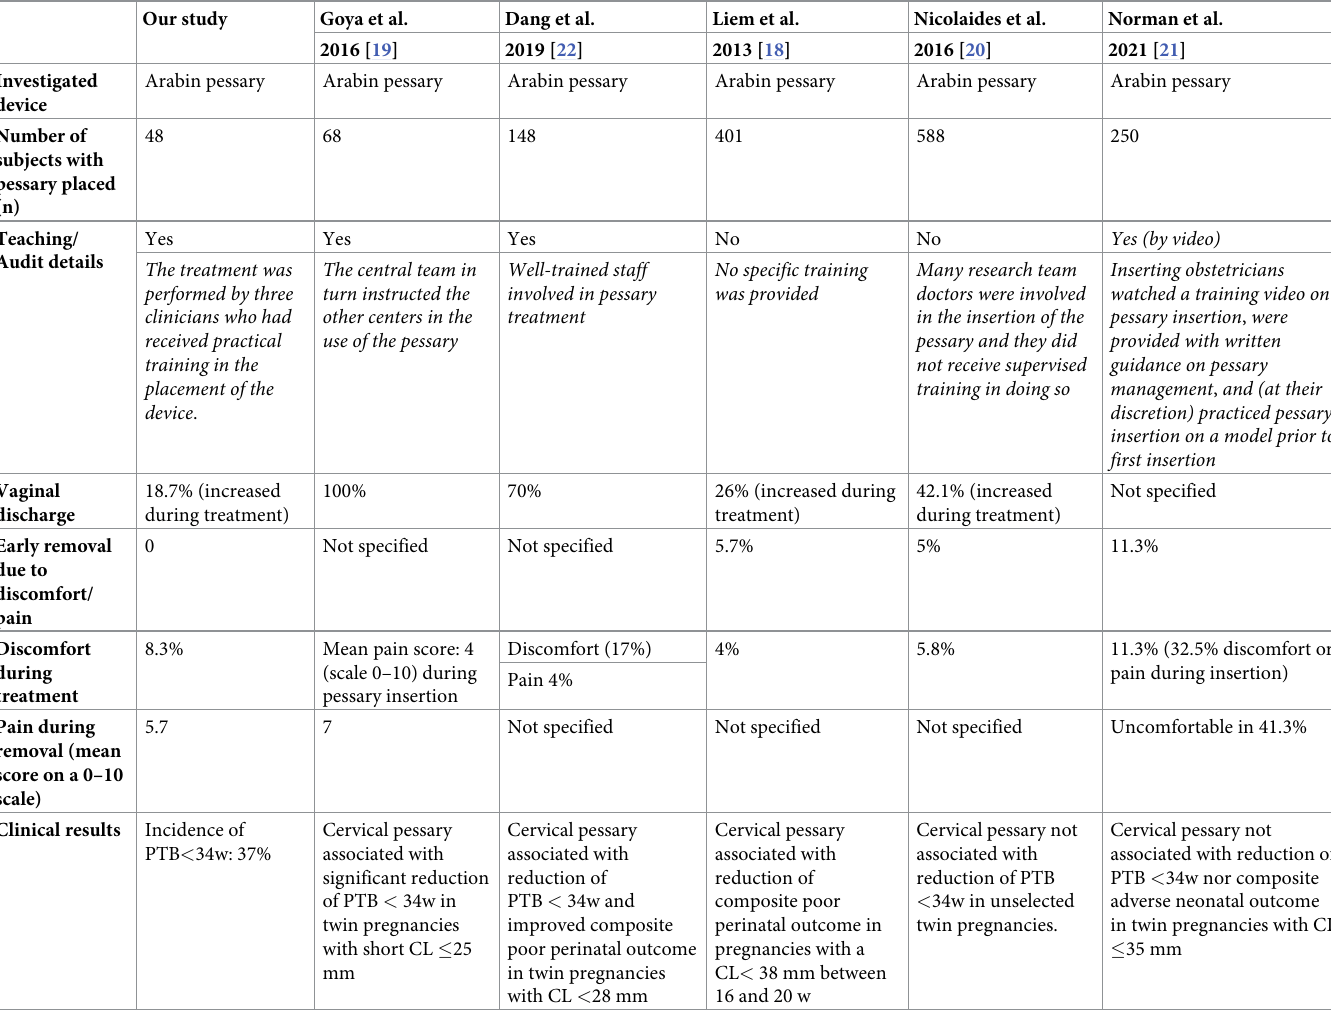
PTB, preterm birth. CL, cervical